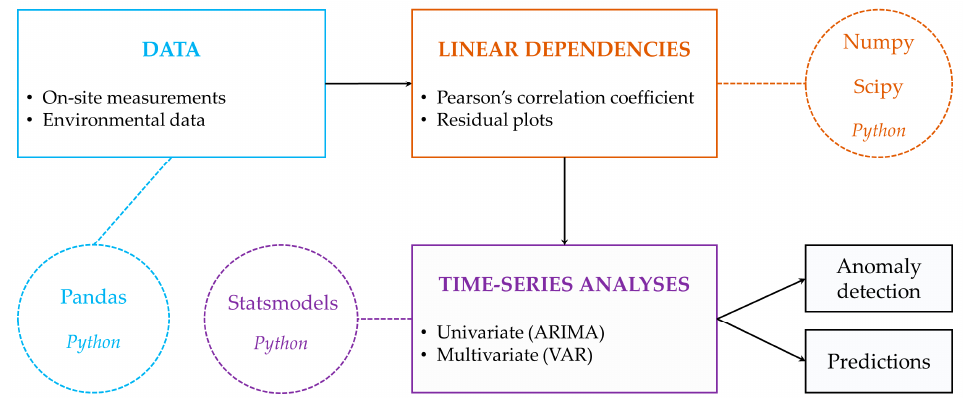
Figure 2. Data analysis pipeline with analysis tools used in the study. The square blocks represent the analysis steps and the circles represent the analysis tools.